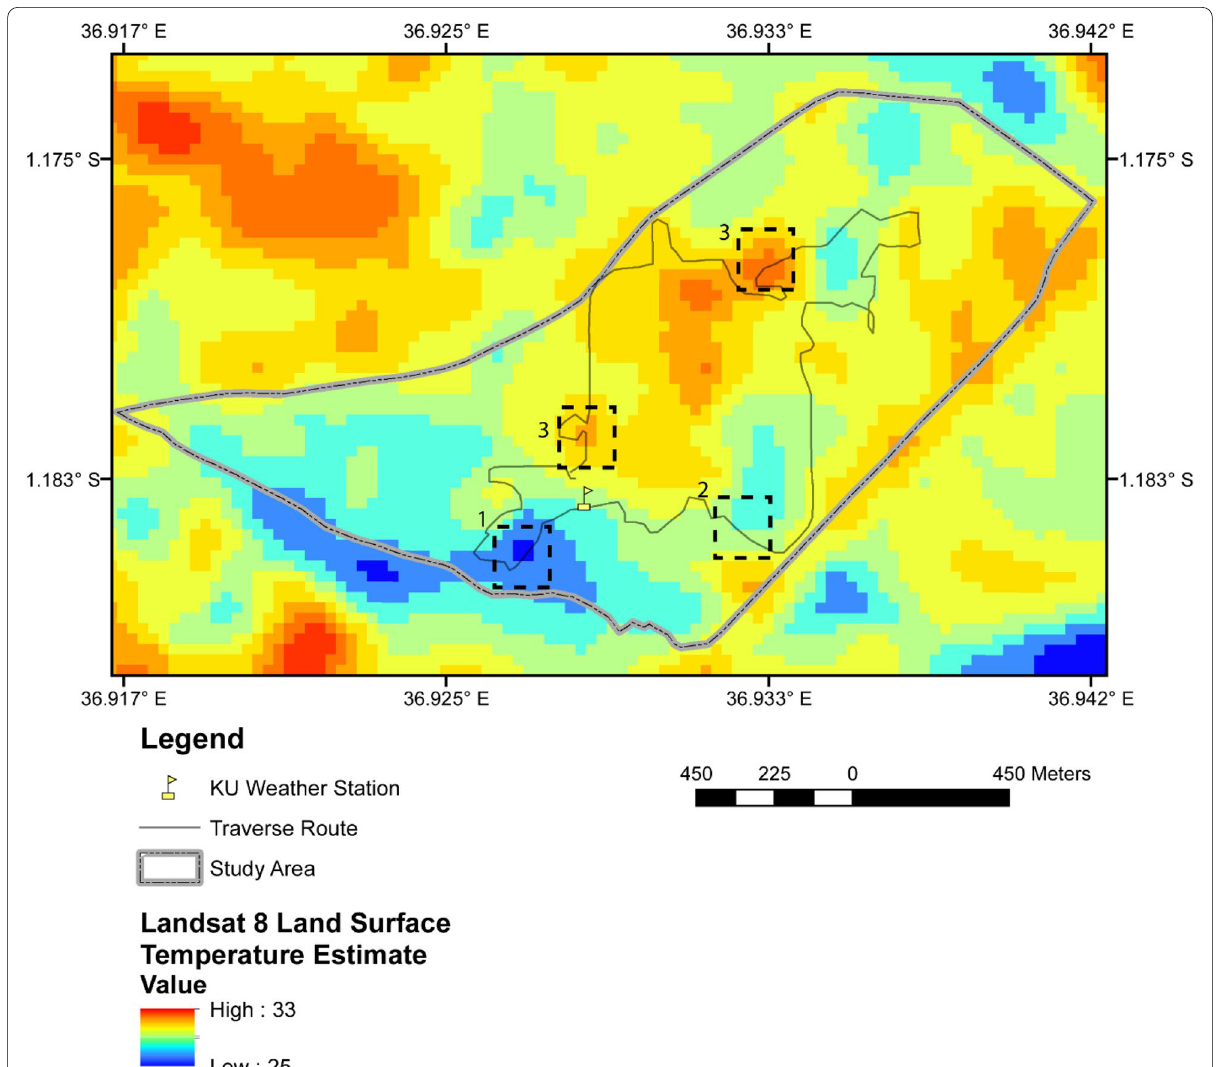
Fig. 12 LST Map of the study area showing areas of low temperature (in blue and cyan) and areas of high temperature (in red and yellow) and late afternoon in situ traverse, as well as the location of weather station where the fixed temperature sensor was located are indicated. The location of significant ΔT clusters coinciding with cold and hots spots are illustrated in enclosed boxes with numbers coinciding with landcover classes described in Table